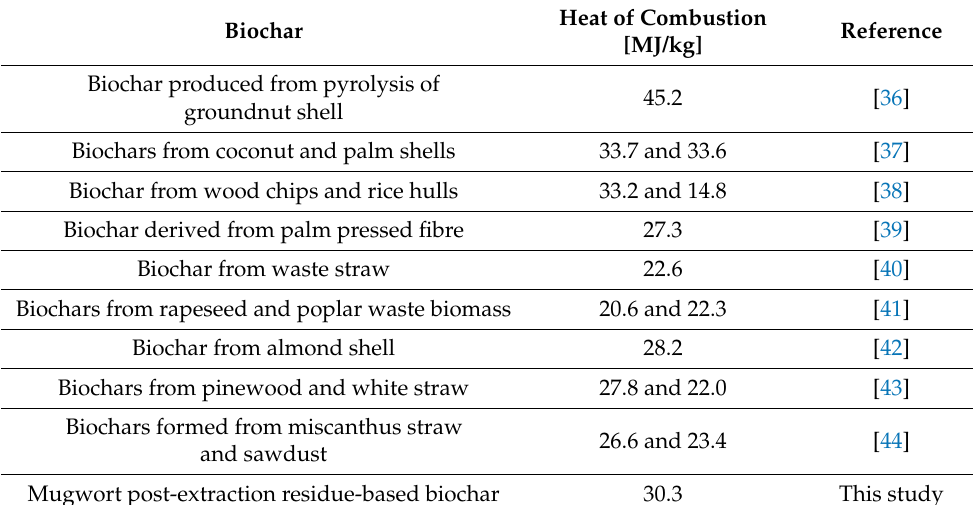
Table 7. Heats of combustion of various biochars.